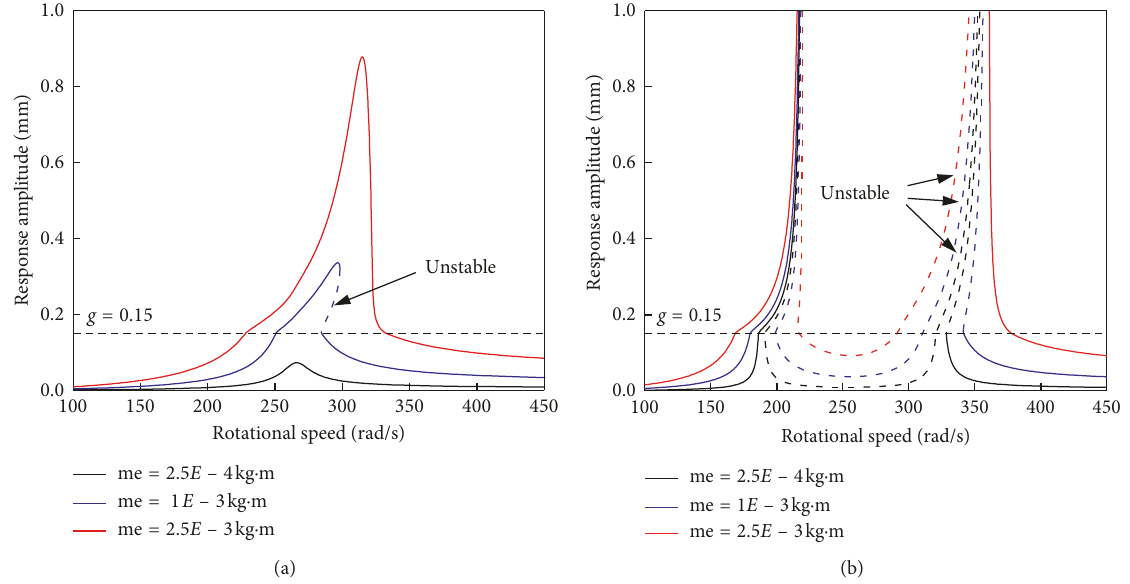
Figure 8: Effects of the unbalance on the horizontal amplitudes of disk node: (a) symmetric rotor and (b) asymmetric